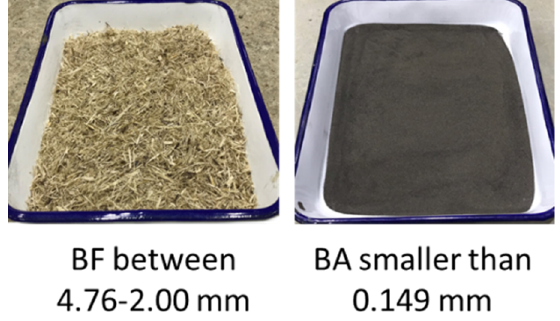
Figure 1. Categorization of sugarcane residual materials.